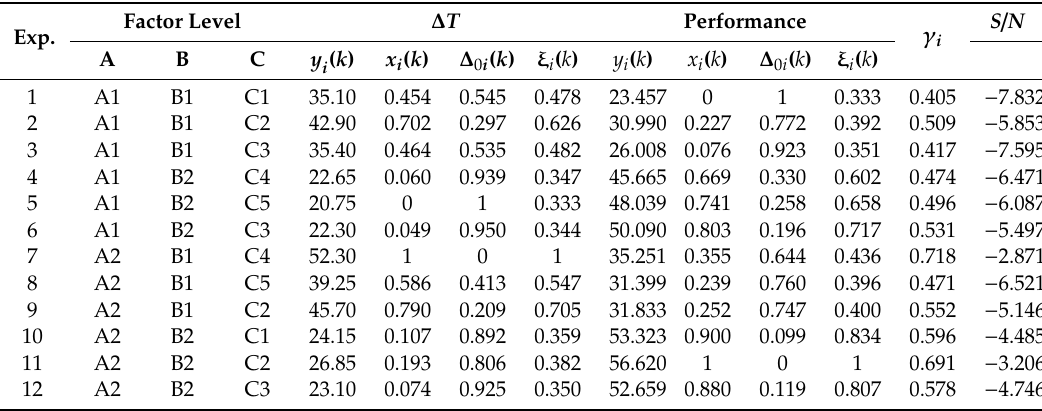
Table 5. The grey rational grades for the solar air heater design. Exp.